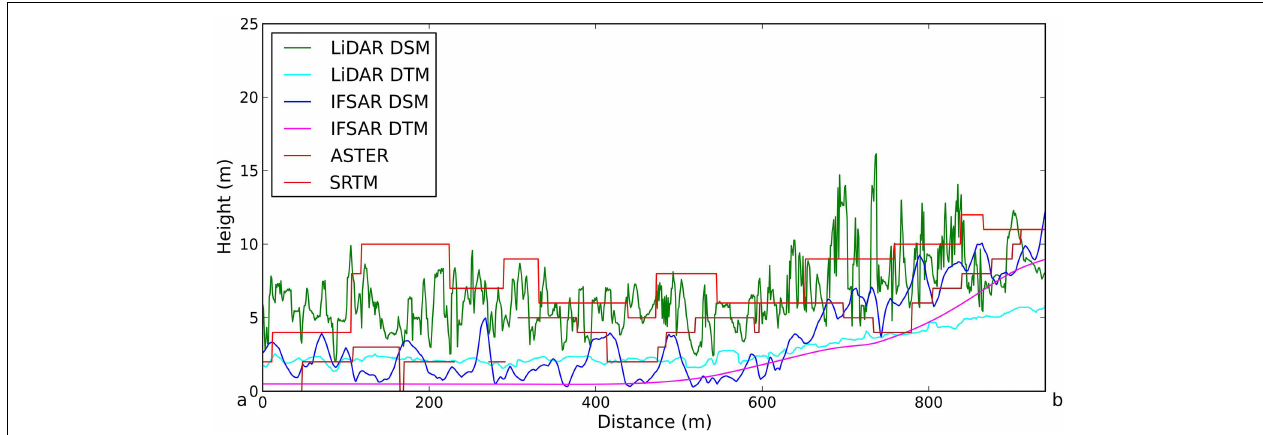
FIGURE 2 | Cross-section of elevation profiles for the different DEM datasets along the line a-b shown in Figure 1A. Note that the ASTER cross-section has discontinuities where there is no data near the